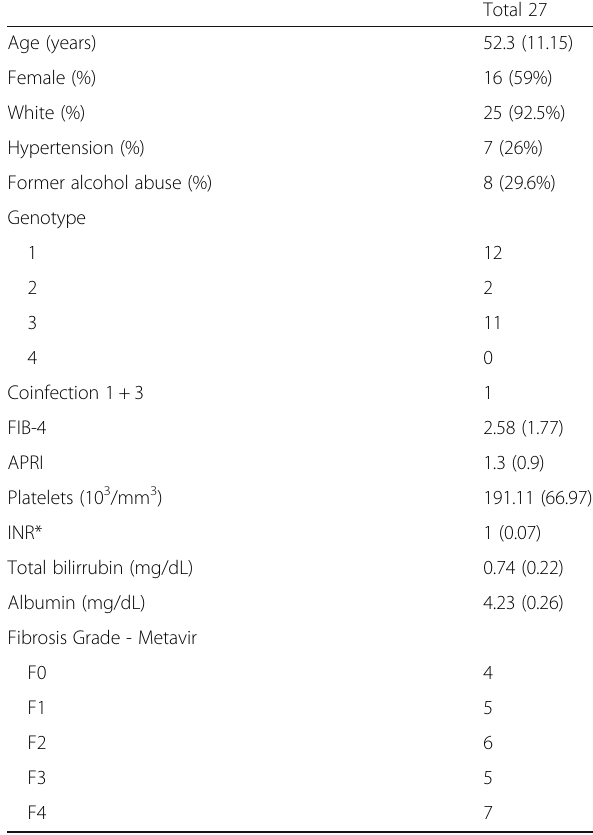
Table 1 Baseline sample characteristics